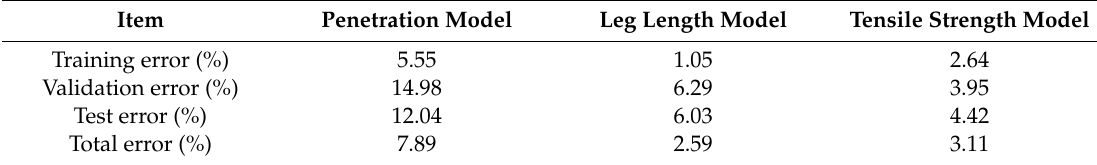
Figure 12. Structure of the DNN models for penetration, leg length, and tensile strength. Table 6. Training results of the DNN models.